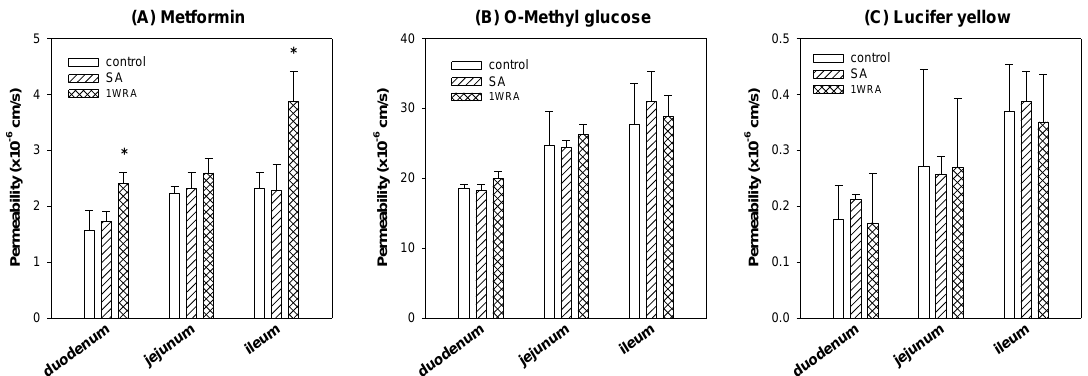
Figure 4. Intestinal absorptive permeability (P app ) of metformin ( A ), 3- O -methyl- d -glucose ( B ), and Lucifer yellow ( C ) was measured in duodenum, jejunum, and ileum segments from rats of control, single RGE treatment (SA), and 1-week repeated RGE administration (1WRA) groups. Data points represent the mean ± SD from three different rats per group; * p < 0.05 compared with control group (by Student’s t -test).